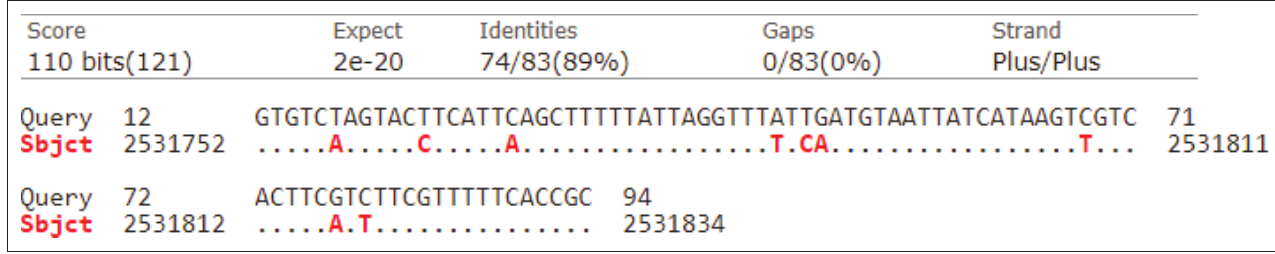
Source : Figure constructed by authors using NCBI-BLASTn online program (https://blast.ncbi.nlm.nih.gov/Blast.cgi). Sbjct, subject. FIGURE 1-A1: BLASTn result showing the alignment of B. bigemina isolate (United Kingdom – LK391707.1) and one sequence ( B. bigemina KZN-Hlabisa isolate) obtained from the study. Nucleotide identity is represented by dots.